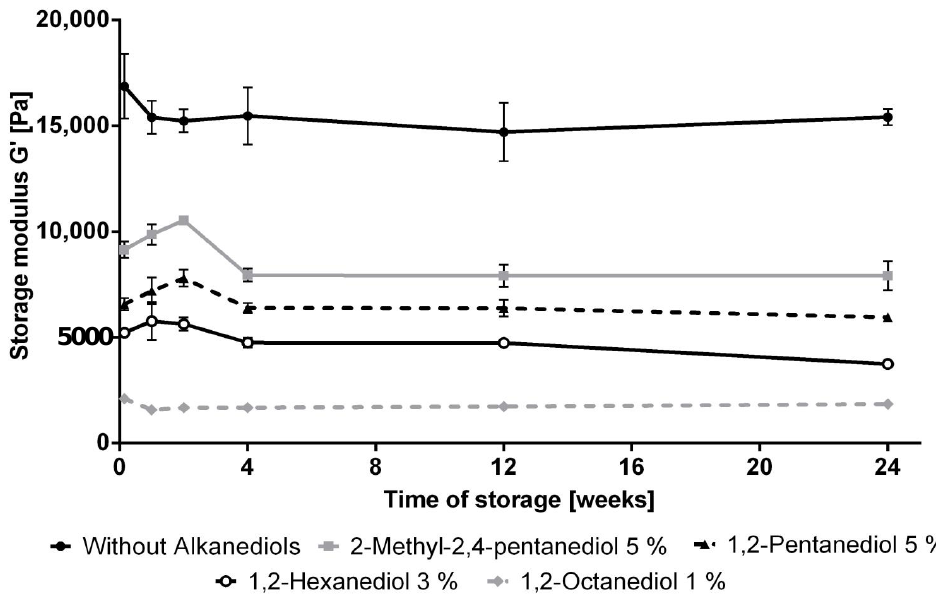
Figure 5. Influence of alkanediols on the storage modulus G’, n = 3, mean ± standard